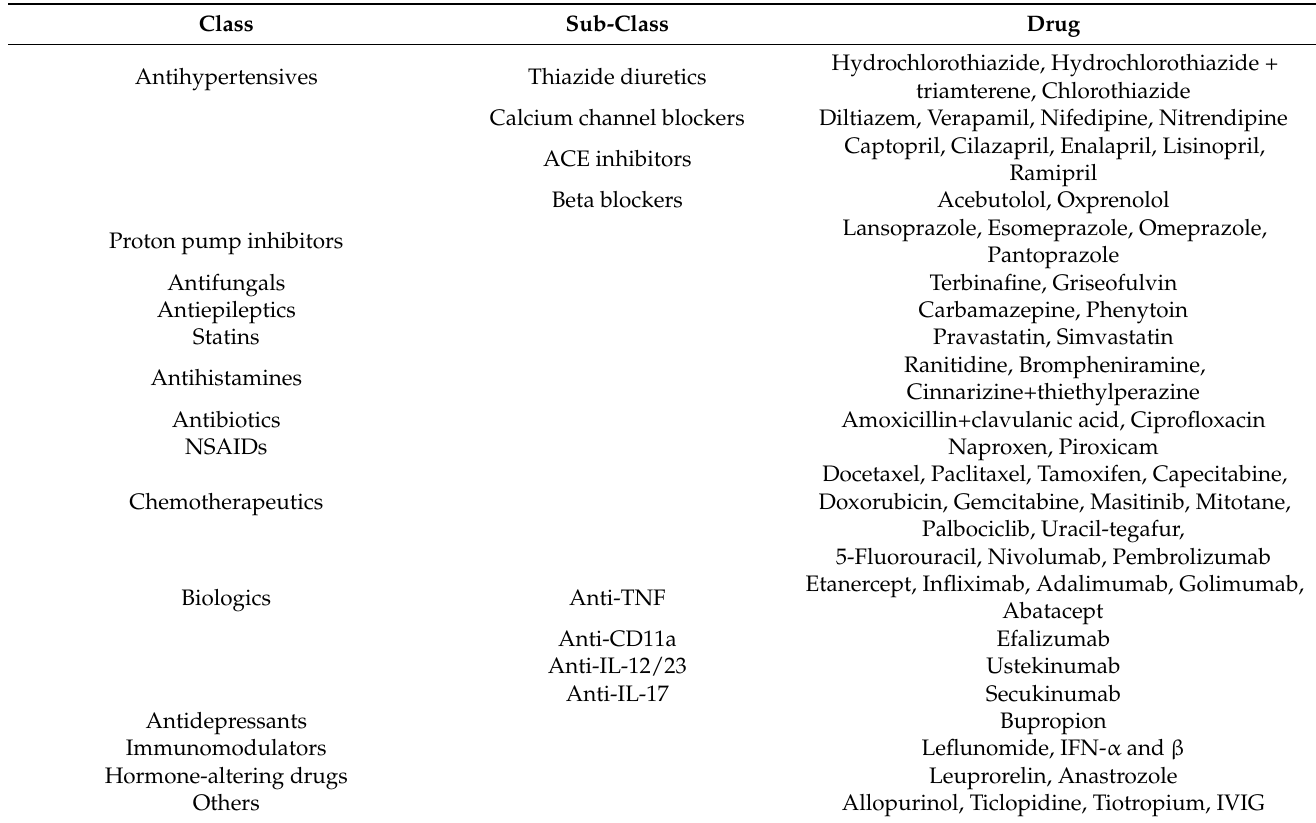
Table 2. Drugs implicated in the induction of DI-SCLE